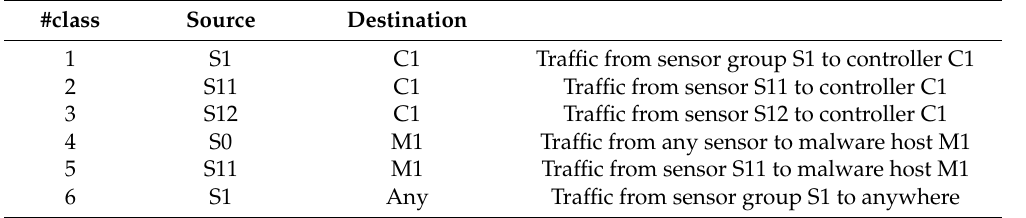
Table 1. Class definitions for the examples in the algorithm and description of the data